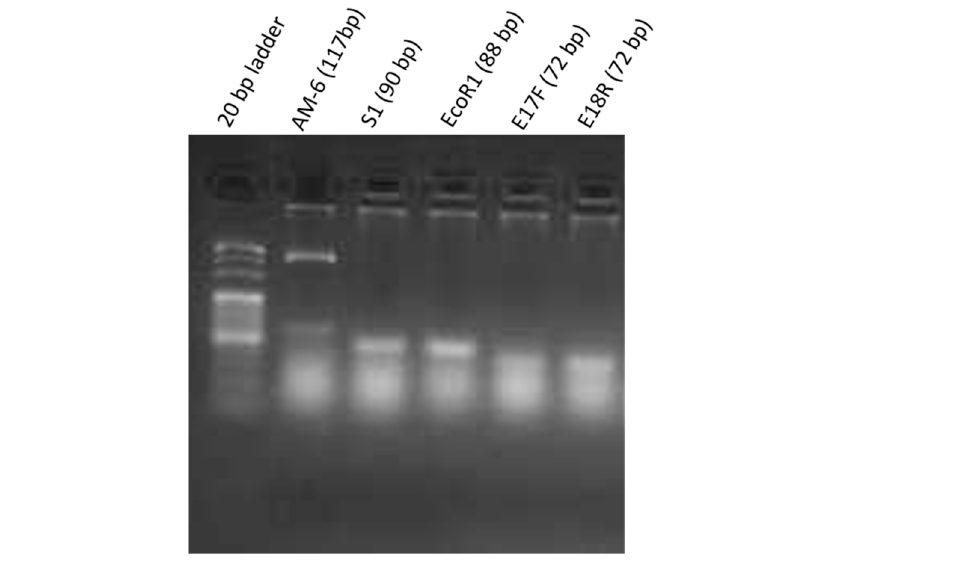
Figure 1. Agarose gel electrophoresis (1.5%) of aptamer amplicons by PCR ( a ) lane 1—20 bp DNA marker, ( b ) lane 2—AM6 aptamer, ( c ) lane 3—S1 aptamer, ( d ) lane 4—EcoR1 aptamer, ( e ) lane 5—E17F aptamer, ( f ) lane 6—E18R aptamer.